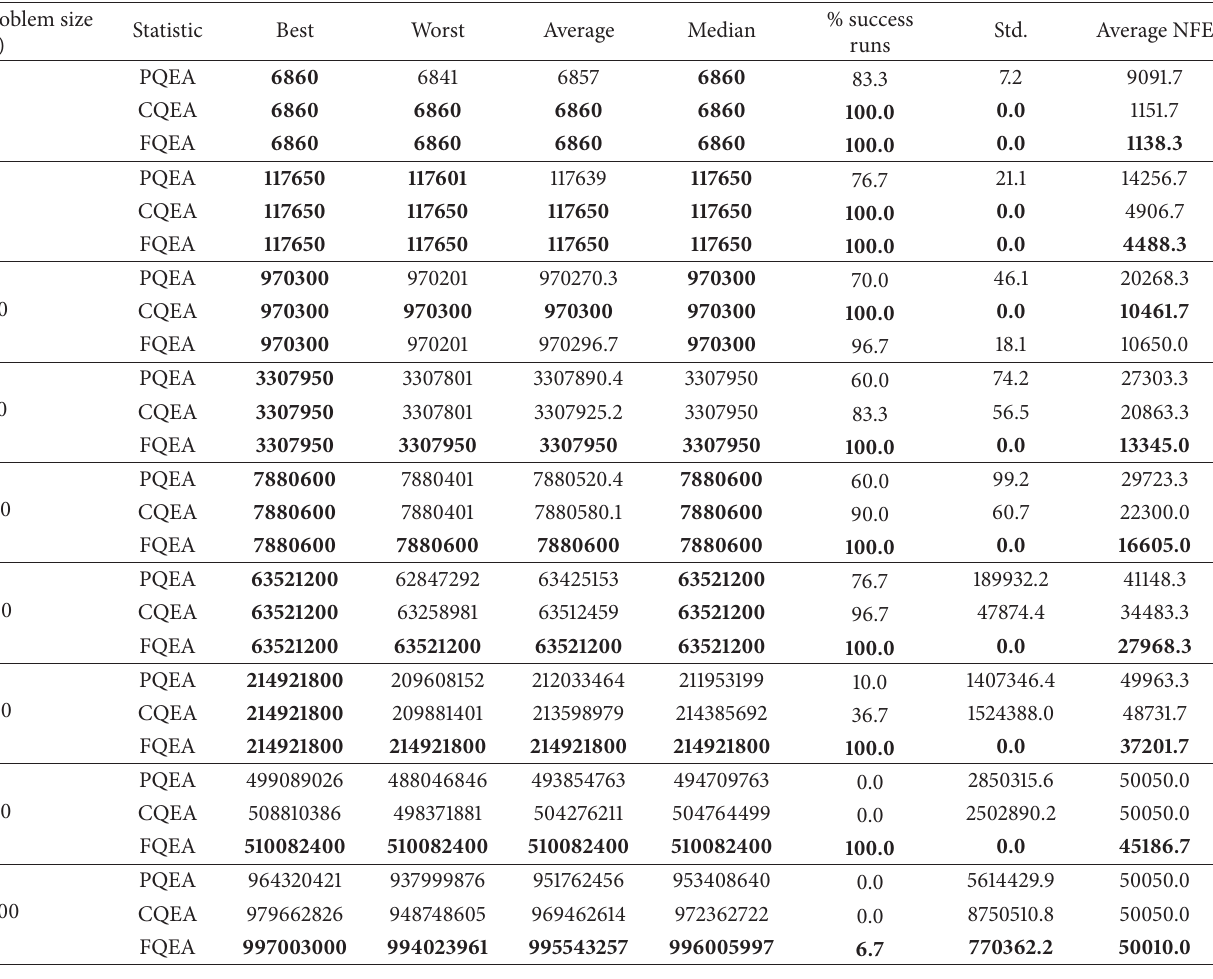
Table 2: Comparative study between PQEA, CQEA, and FQEA using statistical results on COUNTSAT problem instances. Problem size